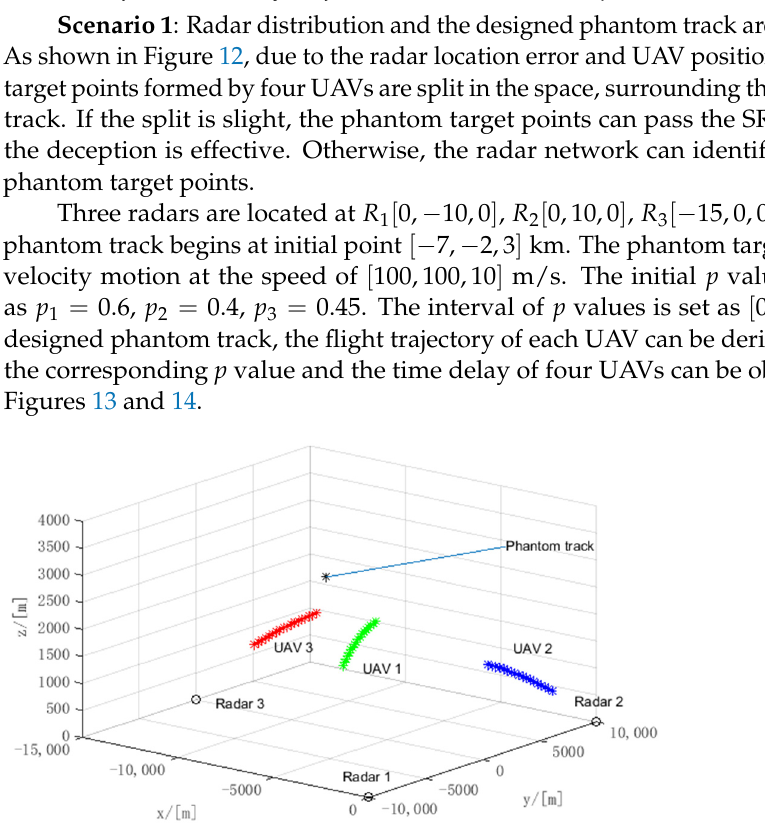
Figure 10. Split distance of phantom targets seen by radar 1 and radar 2. Scenario 1 : Radar distribution and the designed phantom track are shown in Figure 11.